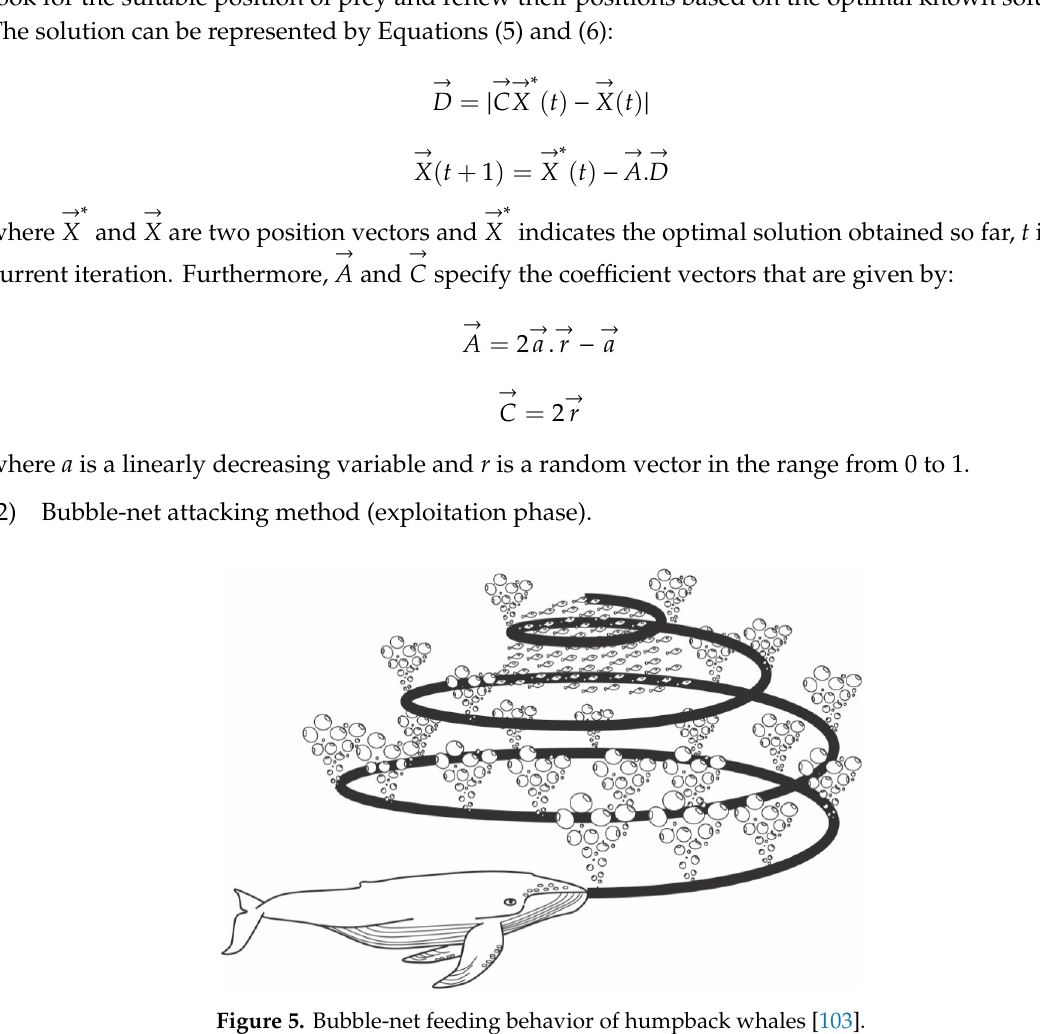
Figure 5. Bubble-net feeding behavior of humpback whales [103].